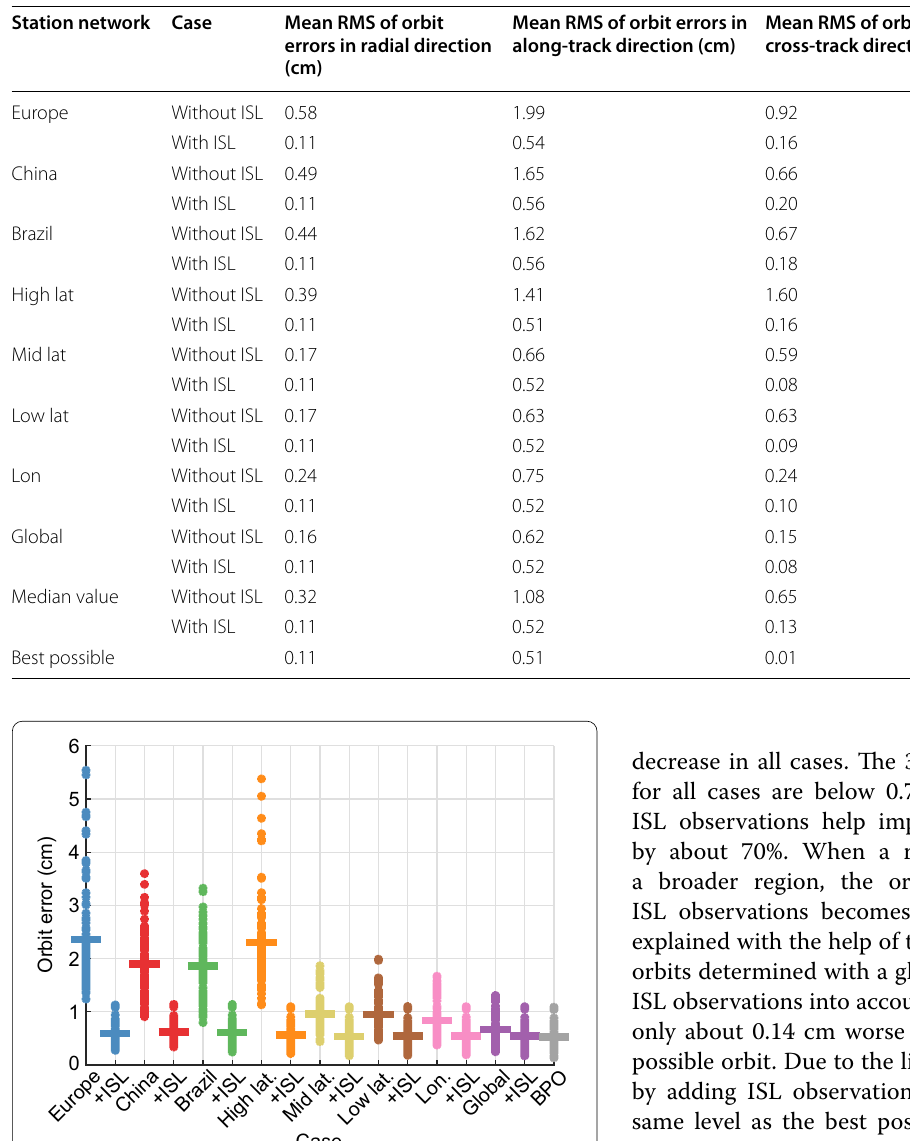
RMS of orbit errors estimated with a regional network is quasi-global network (except high latitude quasi-global), and 65% to global one.